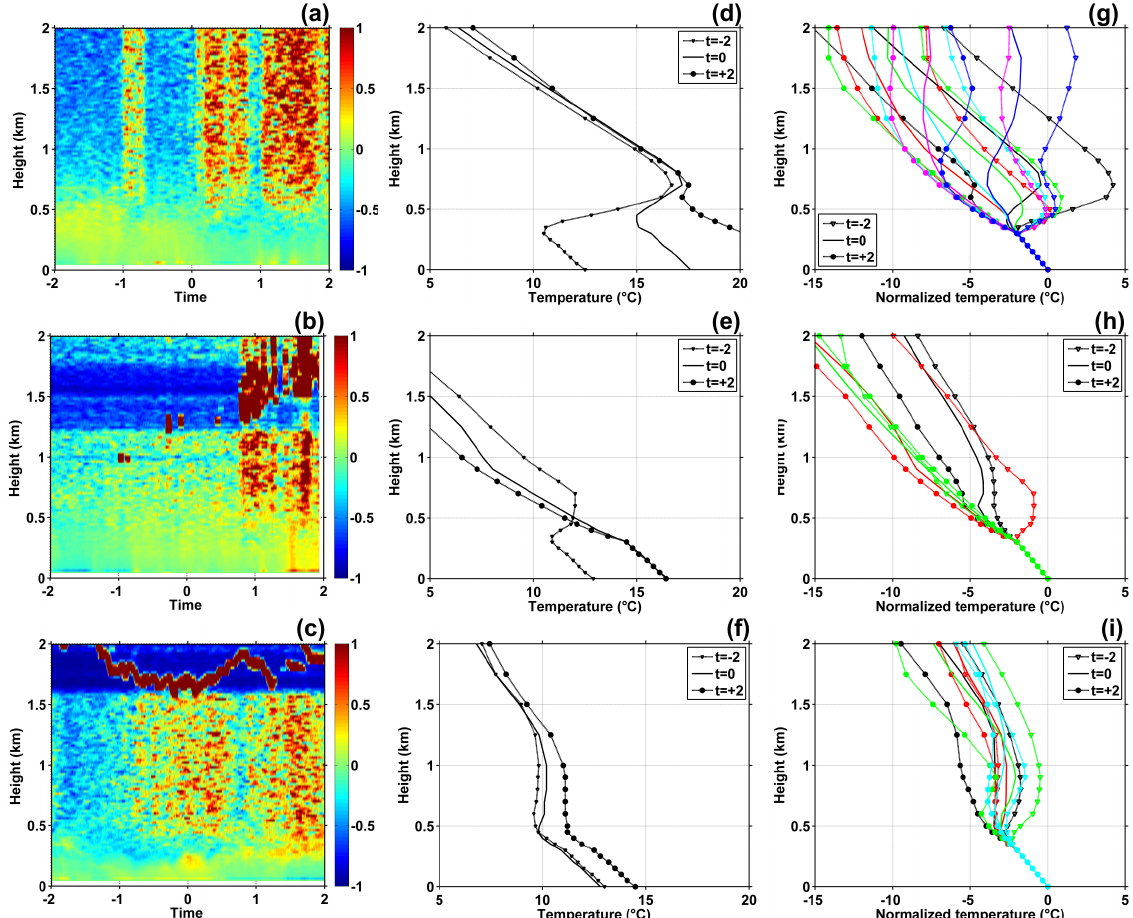
Fig. 6. Examples of relative backscatter signal computed from ceilometers data and vertical temperature profiles (°C) simulated by WRF during a class A event (17 May) (a, d) , class C event (18 May) (b, e) , and non-event (23 May) (c, f) for times t normalized relative to the hour of maximum rate change of 10nm particle number concentrations. The relative backscatter b rel is defined according to (Stratmann et − b(z) , where b(z) is the backscatter measured at the height z and b(z) is the average backscatter at a specific height al., 2003): b rel (z) = b(z) b(z) z during the analyzed time period (06:00 a.m.–12:00 p.m. LST). A moving average filter of 5 min is applied and the vertical resolution is 20 m. Panels in column 3 summarize normalized vertical temperature profiles (°C) simulated by WRF during (g) event class A, (h) event class B and C, (i) non-event days between 14 and 26 May for times t normalized relative to the hour of maximum rate change of 10nm particle number concentrations. Temperatures in (g) , (h) and (i) have been normalized relative to the ground value and different colors refer to different